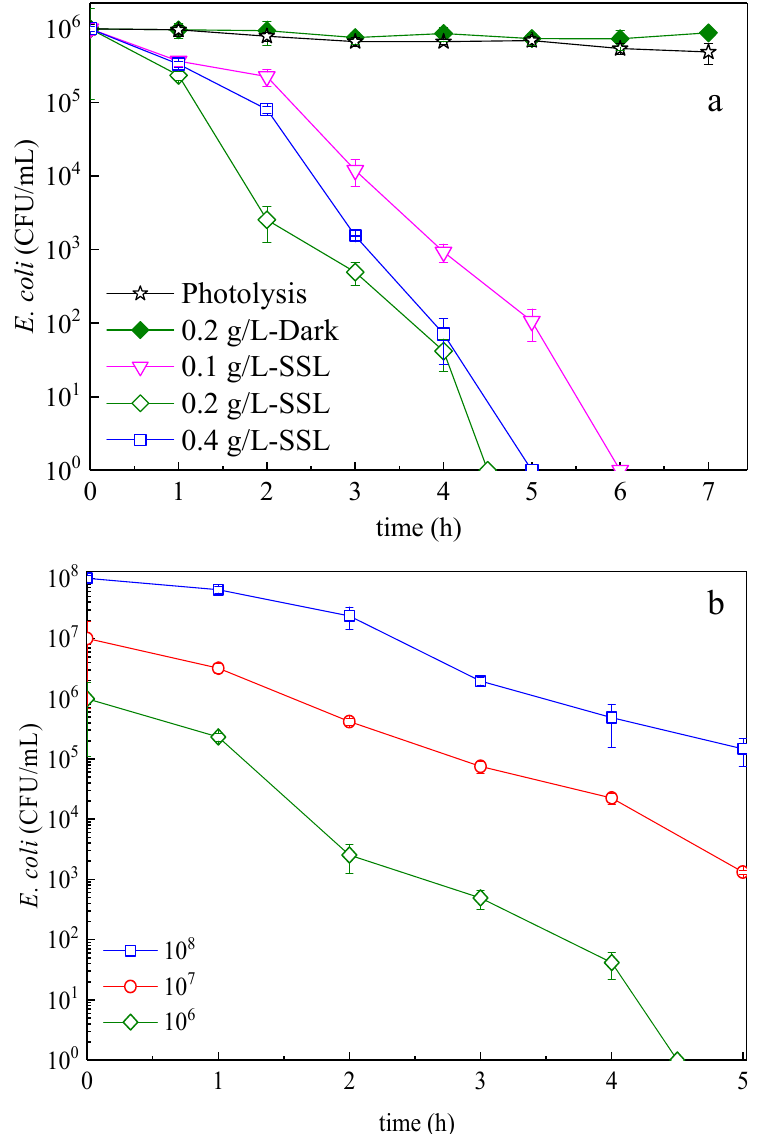
Figure 7. Effect of catalyst and bacterial concentration on inactivation kinetics. ( a ) E. coli survival on Bi 2 WO 6 samples in the dark and under low intensity solar simulated light. Experimental conditions: (bacteria) 0 = 2 × 10 6 CFU/mL and light intensity: 48 mW/cm 2 . ( b ) Initial concentration of E. coli (CFU/mL) effects on the bacterial inactivation kinetics mediated by Bi 2 WO 6 (200 °C for 4 h) under low intensity solar simulated light. Experimental conditions: (Catalyst) 0 = 0.2 g/L and light intensity: 48 mW/cm 2 .